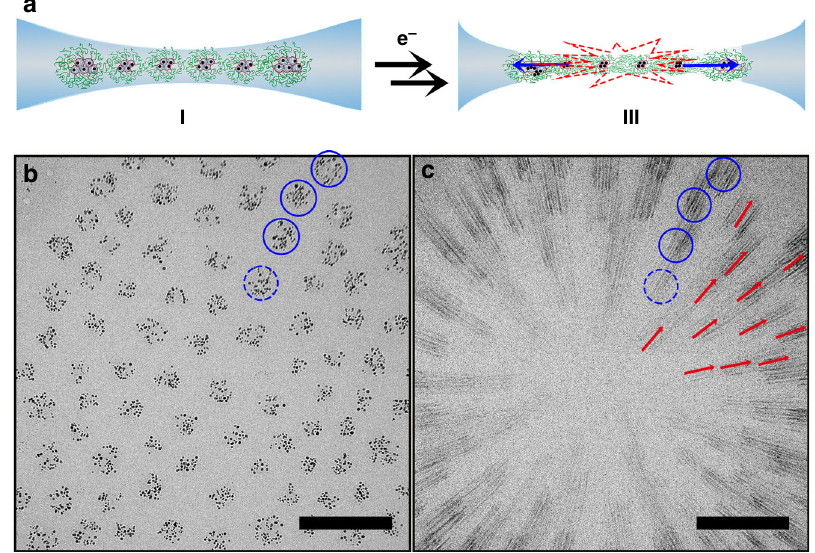
Fig. 2 Electron beam irradiation-induced rupture of monolayer dendrimicelle superstructures. a Prolonged exposure of G6-Au 128 -based dendrimicelles results in the rupture of the thin fi lm in which they are embedded. CryoTEM micrographs of the dendrimicelles superstructure before ( b ) and during the nanoexplosion ( c ). Because of the relatively long exposure time and the contrast provided by the gold nanoparticles, the rupture process is captured as streaks. The rupture starts from the center of the dendrimicelle superstructures (as indicated with an asterisk) and radially propagates outwards. The blue solid circles are drawn as a guide to the eye around four dendrimicelles before and after rupture. The red arrows are drawn as a guide to the eye to show the directionality of the nanoparticle streaks. Scale bars are 100